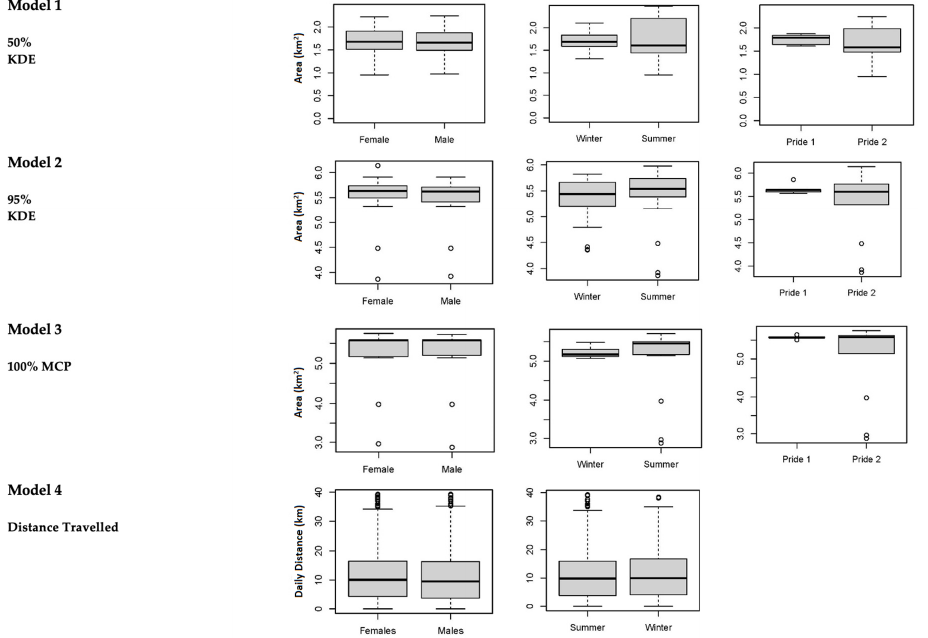
Figure 4. Differences in home range size and movement metrics for the different variables tested for lions at the Tula Tsau Conservation Area, between 2010 and 2011 (Royal Pride) [Pride 1] and 2018 and 2020 (Tsau Pride) [Pride 2]. Box plot method was used; showing upper and lower limits, the median value, and open circles indicate outlier values.